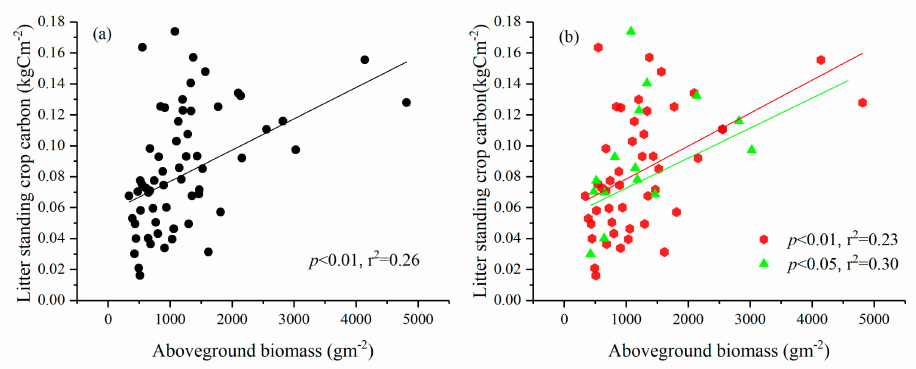
Figure 5. Relationships between aboveground biomass and litter standing crop carbon, ( a ) total shrublands, ( b ) red circle means alpine shrublands, green triangle means desert